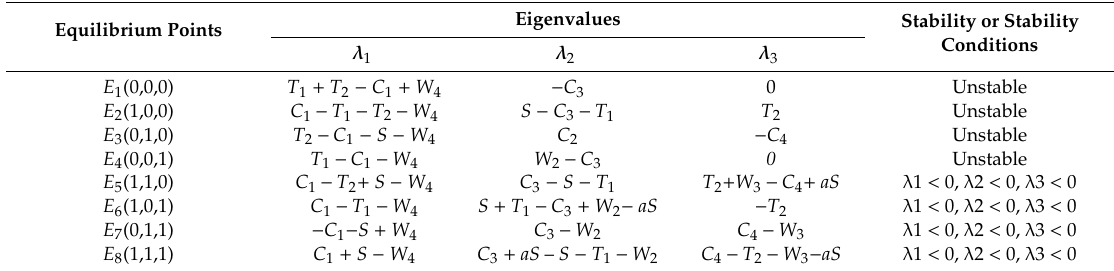
Table 3. The system equilibrium points and their